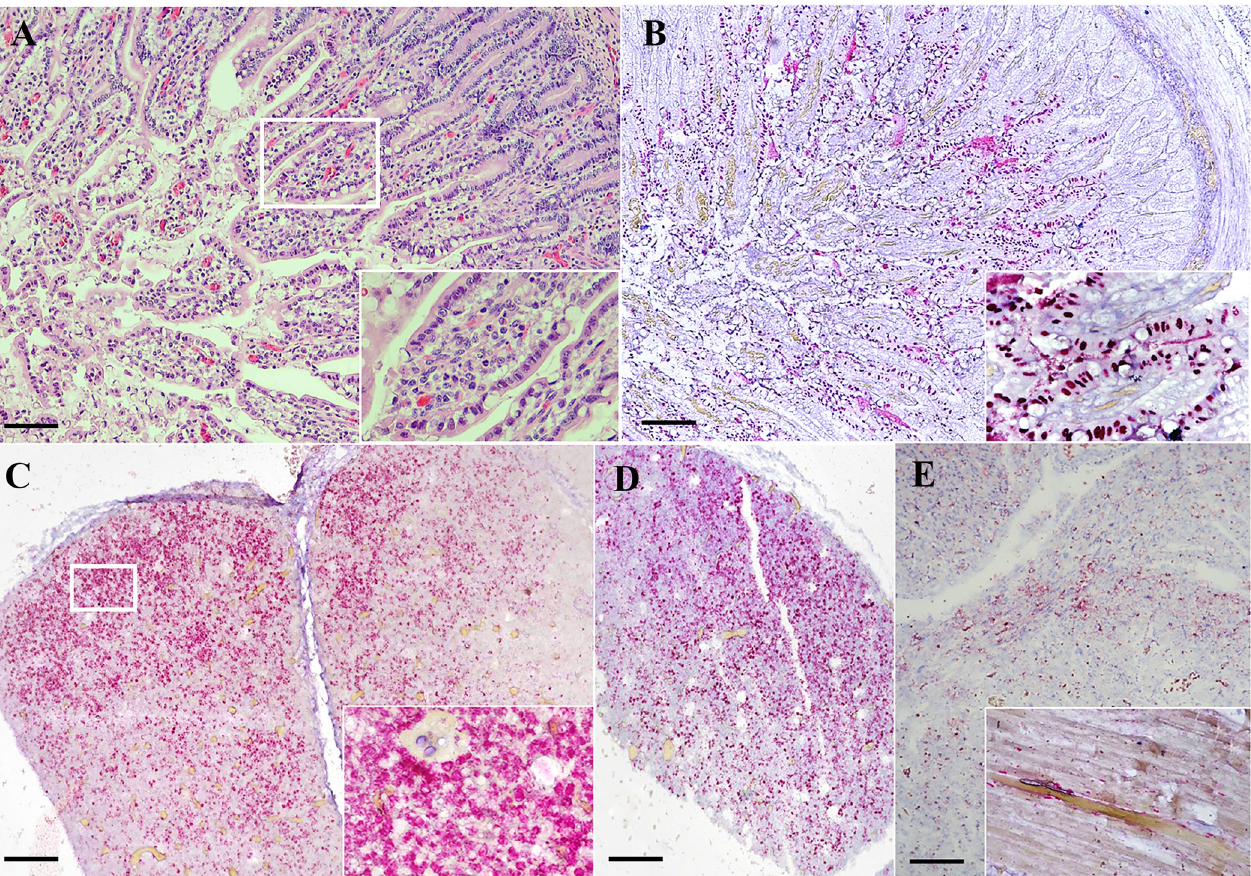
Fig 4. CBoV-2 infection in dogs no. 008CP4 (A-B) and no. 038CP3 (C-E). Photomicrographs demonstrate H&E staining (A) and CBoV-2 ISH (B–E). Variable numbers of enterocytes contained large, bright eosinophilic, intranuclear inclusion bodies (inset). (B). Diffuse strong hybridization signals were localized in the nucleus of enterocytes (red precipitates), the cells of which contained inclusion bodies (inset). (C) Strong hybridization signals were observed in the nucleus of mononuclear cells (inset) of the thymus and (D) mesenteric lymph nodes. (E) Nuclear hybridization signals were observed in myocardial cells (inset). Hematoxylin (pale blue) was used as a counterstain. Bars indicate 25 μ m (A–E).